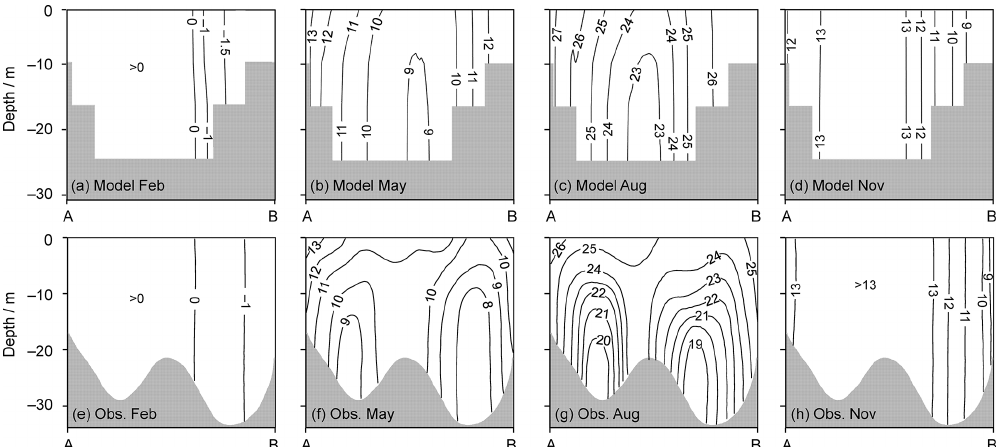
Figure 6. Comparison of vertical profiles of water temperature ( ◦ C) along transect A–B (locations shown in Fig. 1) between NEMO-Bohai (a–d) and the marine atlas of the Bohai Sea (Chen, 1992) (e–h) in February, May, August, and November.